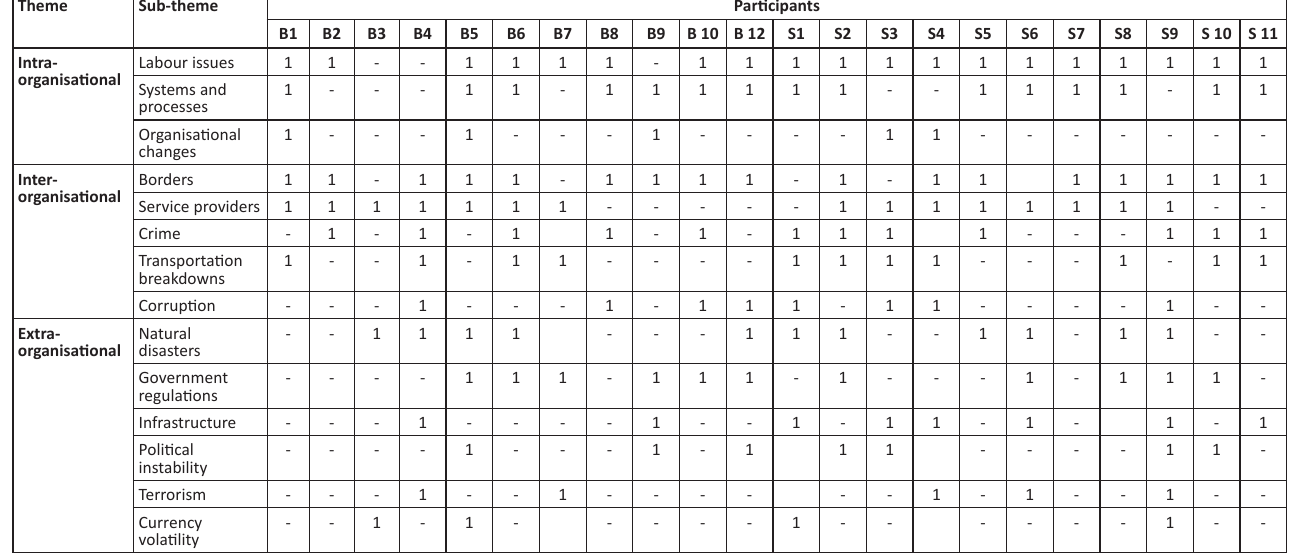
FIGURE 3: Frequencies of disruptions for South African 3PLs and their